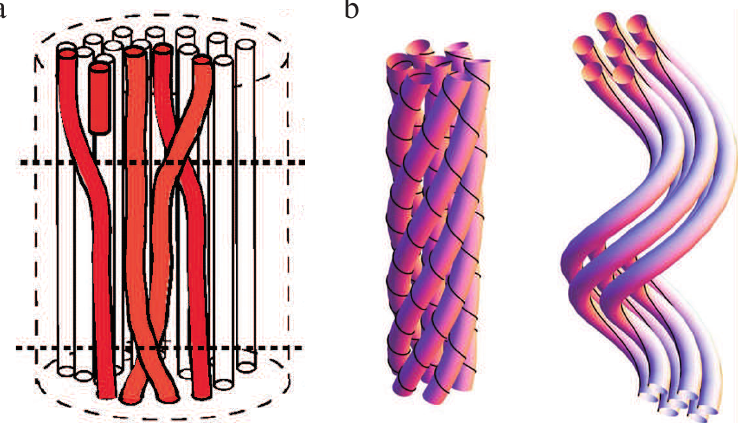
Figure 7. ( a ) Structural defects of the inner-bundle geometry impede the energy minimization during the bundle formation process, thus limiting the bundle size [87]; and ( b ) the molecular structure of the filaments impact the overall bundle geometry. Chiral filaments twist themselves around the bundle axis ( left ) while helical filaments cause a writhe of the bundle axis ( right ) [89]. Figures are adapted from N.S. Gov and G.M. Grason